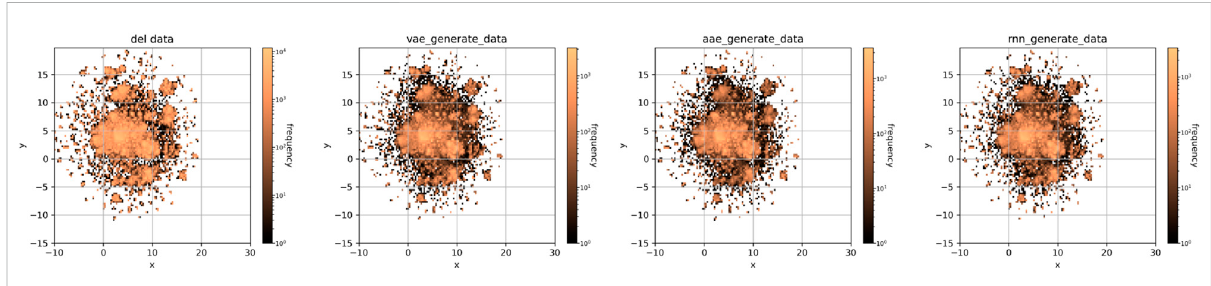
FIGURE 2 Dimensional reduction visualization of the training and generated molecular datasets (from left to right: DEL, VAE, AAE, and RNN).